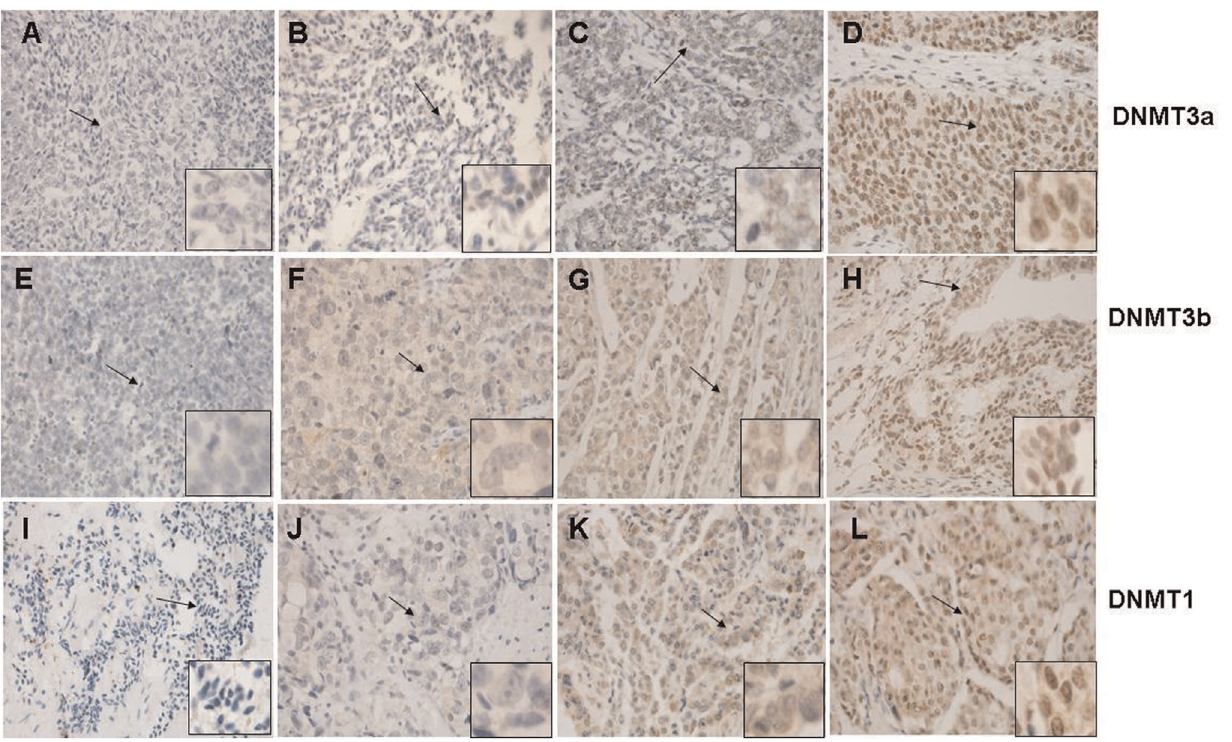
Figure 1. Immunohistochemical staining of DNMT3a, DNMT3b, and DNMT1 proteins in ovarian cancer tissues. Representative examples of negative (A, E, I), weakly positive (B, F, J), moderately positive(C, G, K), and strong positive (D, H, L) immunostaining for DNMT3a, DNMT3b, and DNMT1 expression are shown, respectively; Arrows indicate the field enlarged. Magnification: 6 400; enlarged sites: 6 1000.